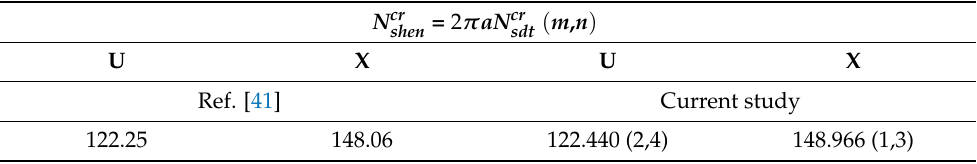
Table 1. Comparison of critical axial load of cylinders reinforced with U- and X-model in the thermal environment within